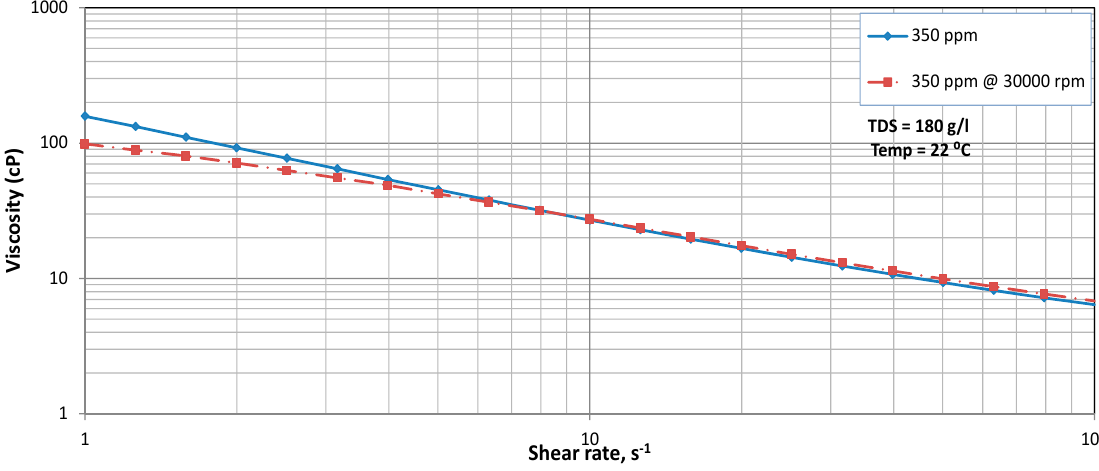
Figure 7. Effect of shearing on biopolymer solution viscosity (SAMA). Brine TDS = 180 g/L